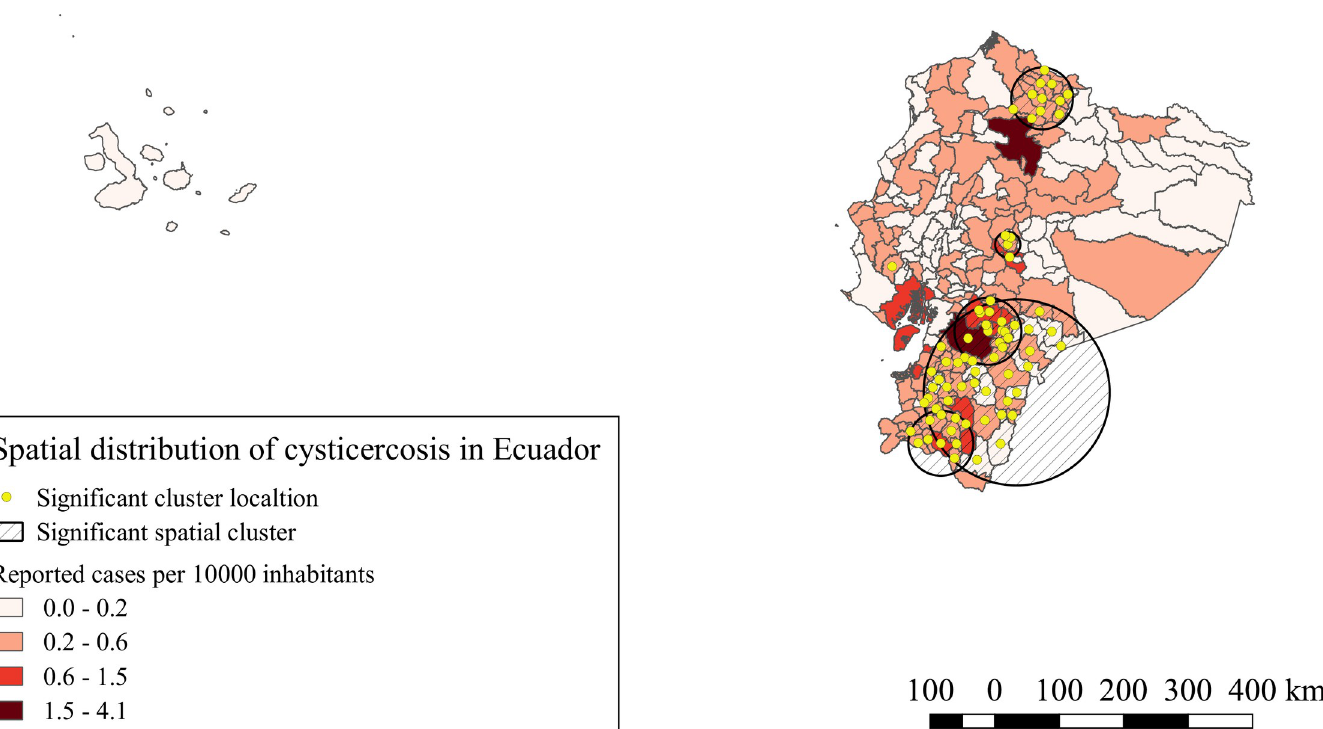
For hospitalized hydrocephalus cases, 6 significant spatial clusters were identified clusters. There were four bigger clusters, two in the southern part of the highlands and part of southern coast provinces, one more was located in the central-north provinces of the highlands and one in a northern province of coast, two single canton significant clusters were also